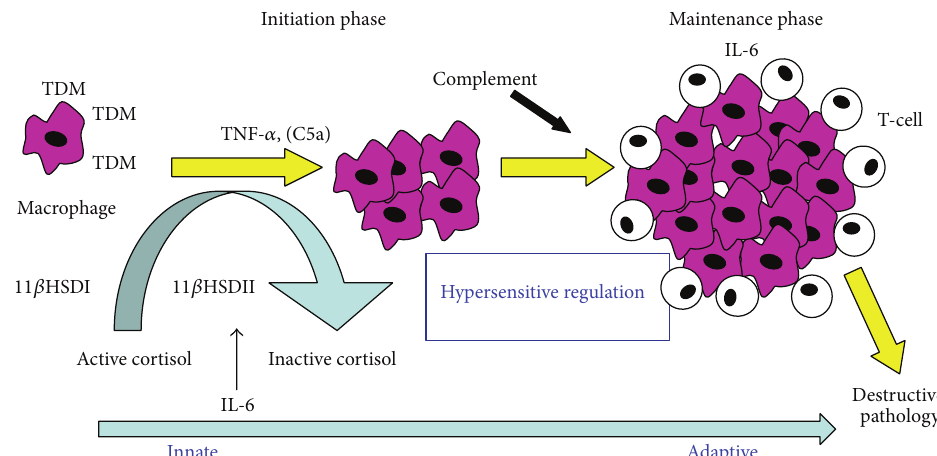
Figure 1: Mechanisms of TDM-induced granulomas. Cytokines and immune-regulatory factors induced by mycobacterial glycolipid TDM play key roles in the development of pathology induced during mycobacterial infection. Model systems using isolated TDM allow identification of host immune function to extrapolate findings of immune related pathology occurring during clinical manifestation of tuberculosis disease [17, 33, 37, 38, 41, 52–58].